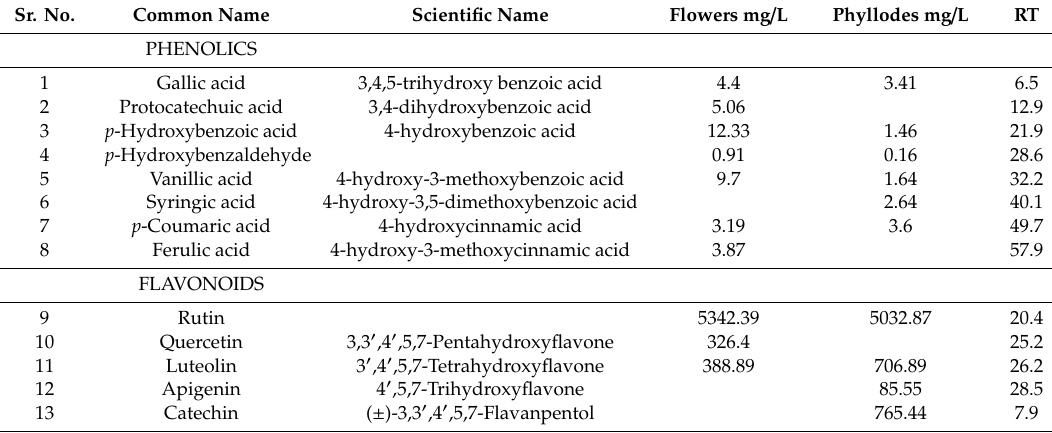
Table 5. Phenolics and flavonoids found in flower and phyllode extracts of Acacia melanoxylon R. Br. RT: retention time (minutes) of compounds in column.